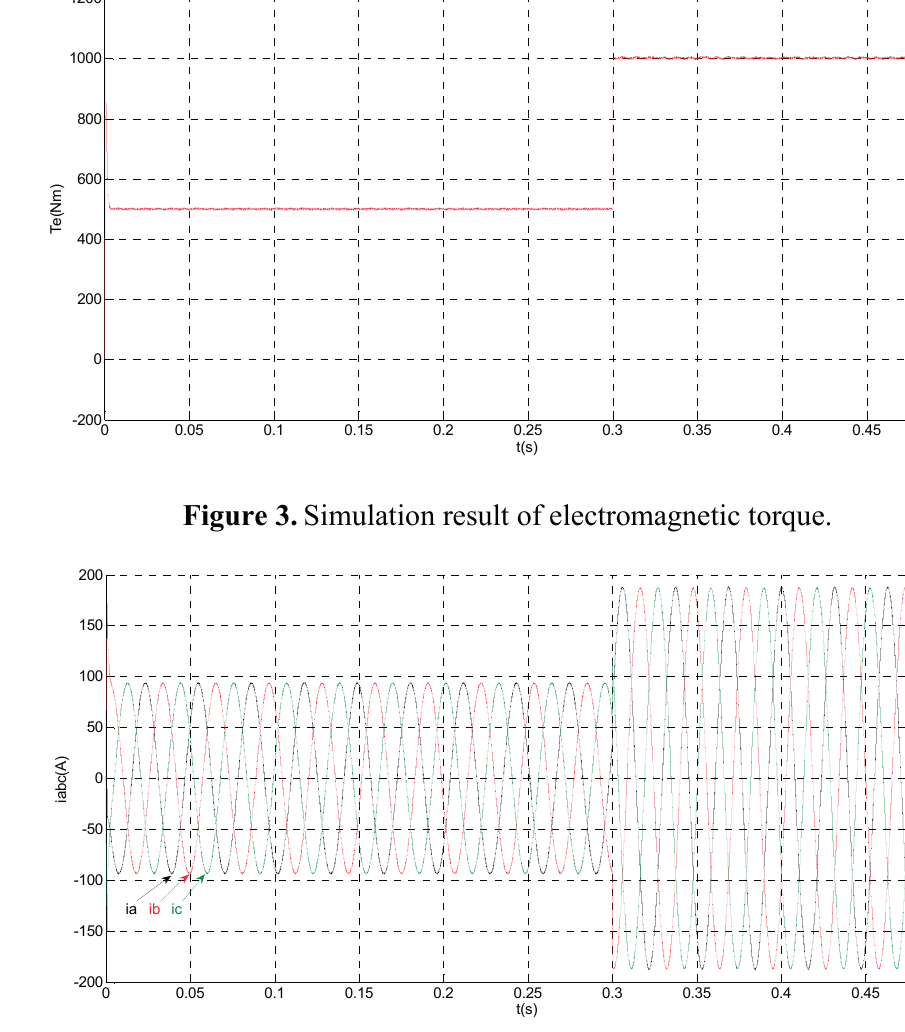
Figure 4. Simulation results of measured phase